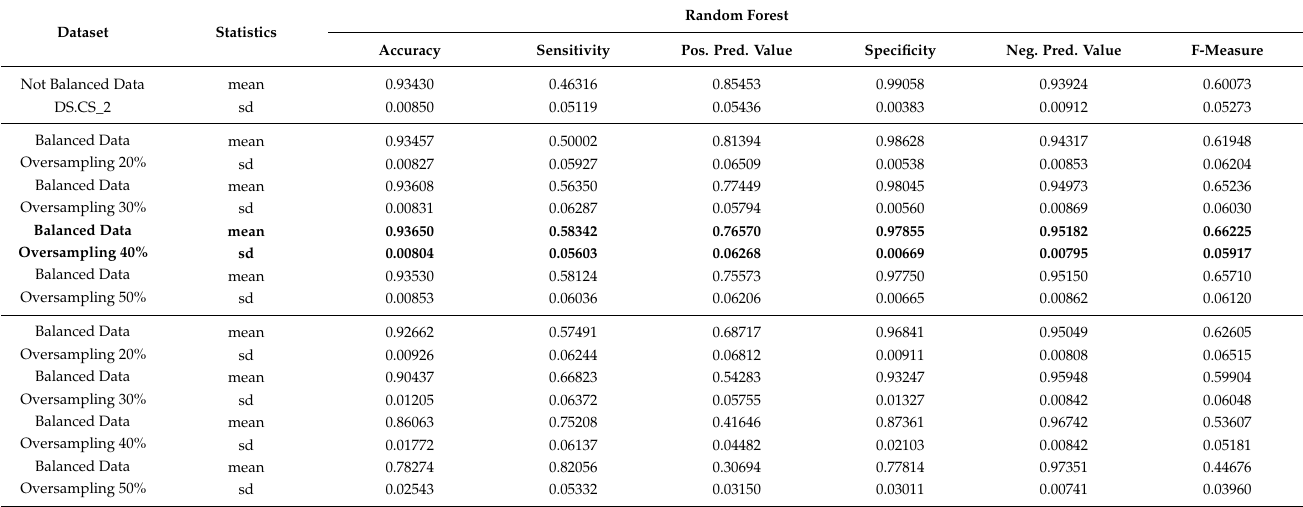
Table 6. Data balancing evaluation: Random